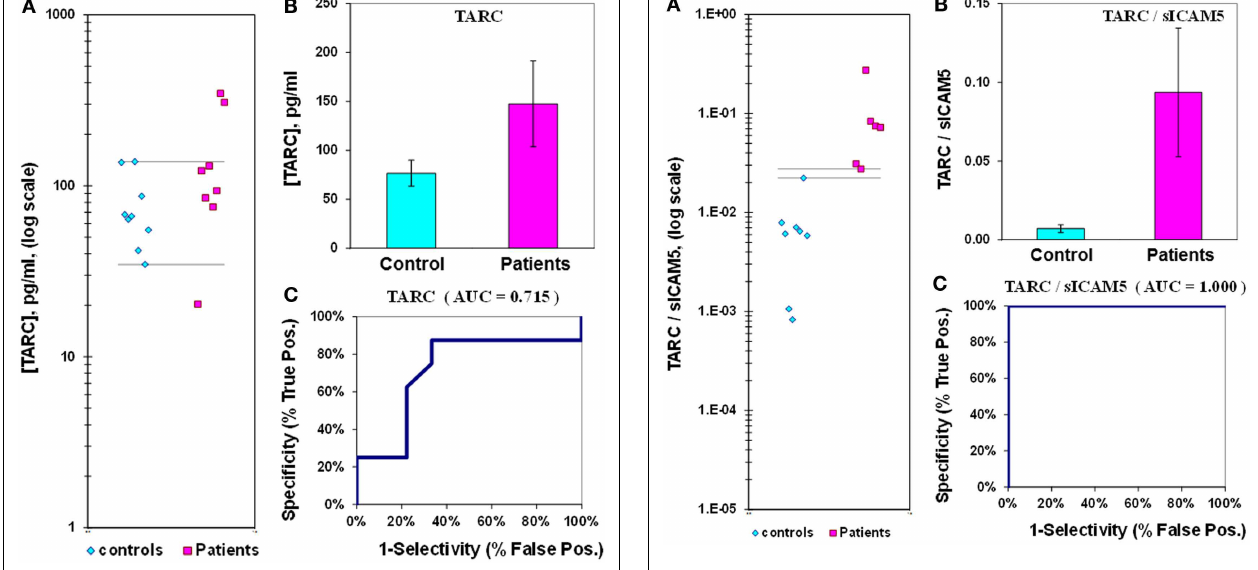
FIGURE 7 |TARC/sICAM5 ratio in plasma from epilepsy patients and controls. (A) Dot-plot ofTARC/sICAM5 concentrations in plasma (square, patients; diamond, controls).There are no values between the horizontal lines, indicating the assay accurately discriminates between patients and controls. (B) Bar graph and error calculation for data in Part (A) . Difference is 13-fold, and is significant for p = 0.034. (C) ROC curve for data in Part (A) , showing an area under the curve (AUC) value of